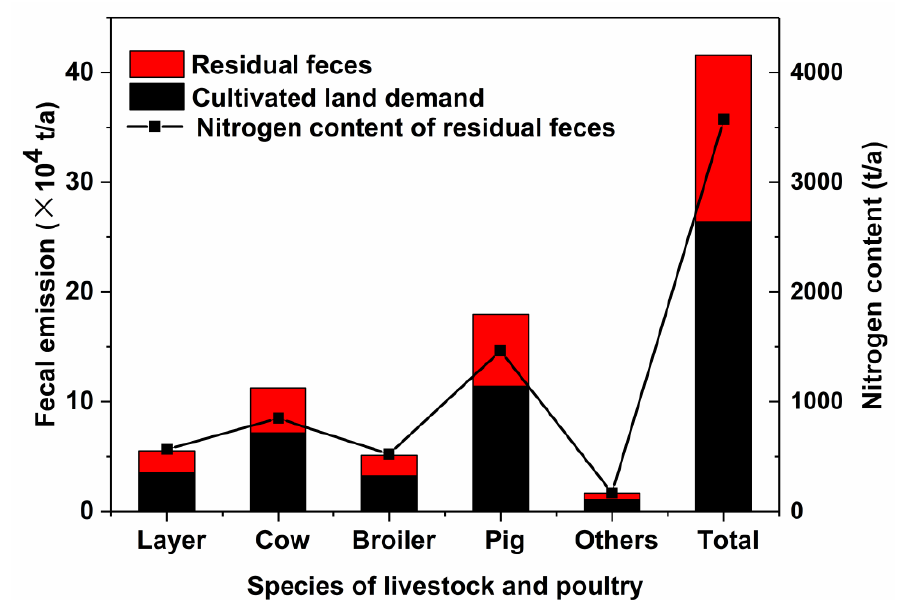
Figure 7. Livestock manure and nitrogen nutrient residuals.